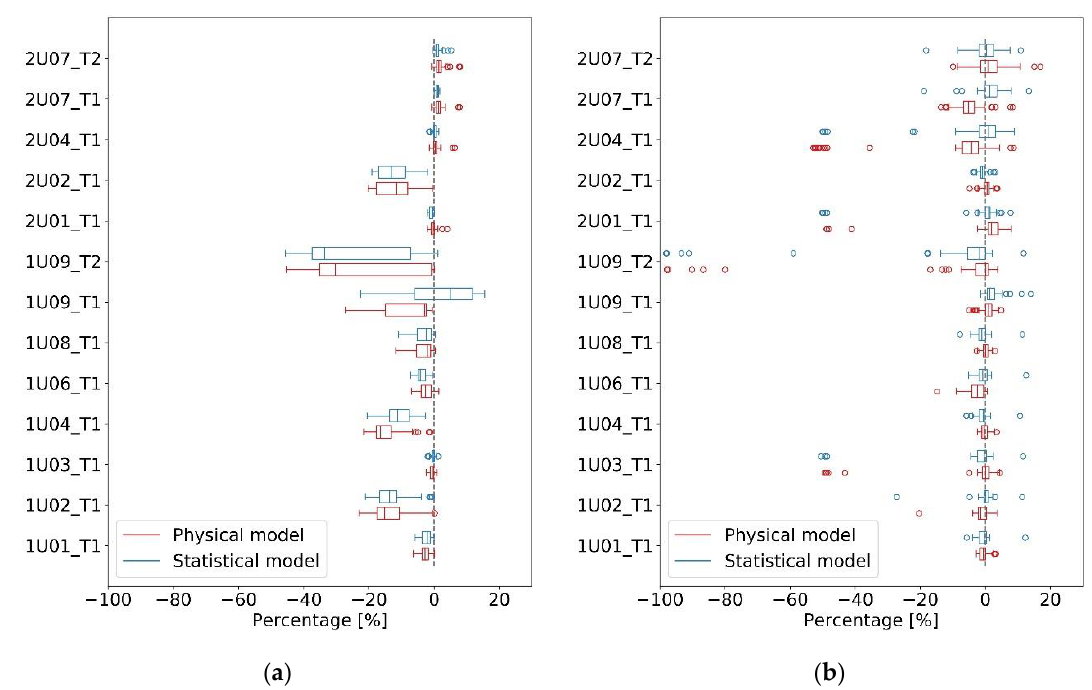
Figure 13. Boxplots of RVPI ( a ) and RCPI ( b ) for a selected subset of MPP trackers calculated using physical models and statistical models.